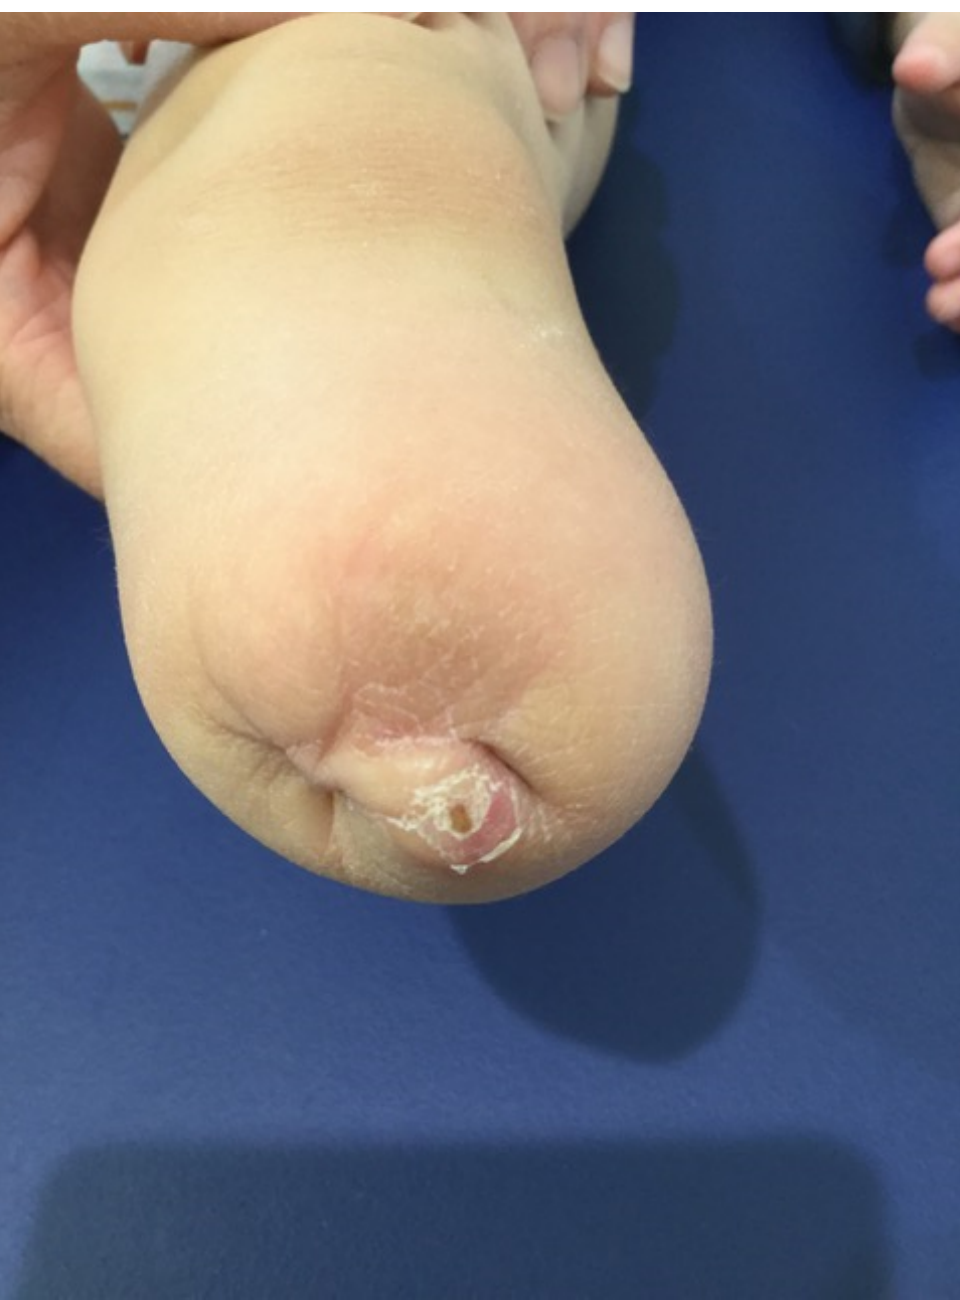
Figure 4 . A clinical image showing an unfamiliar observation of the fibula outgrowing the tibia in an amputated case .